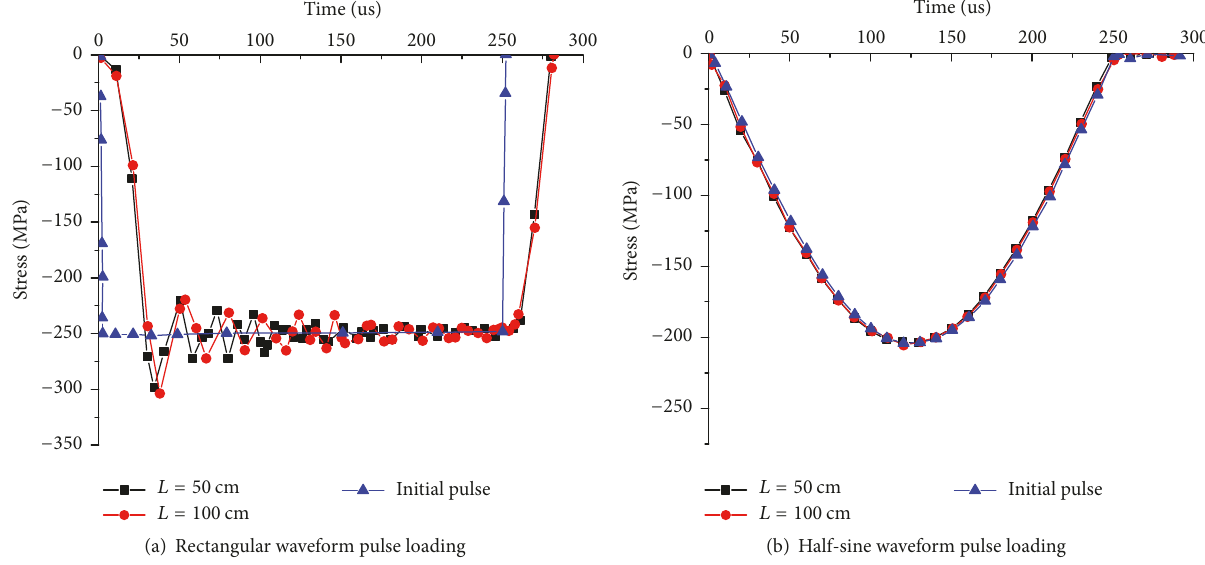
Figure 6: Time-history of stress pulses at different propagation distances ( 𝐿 ) away from the impact end of the input bar.